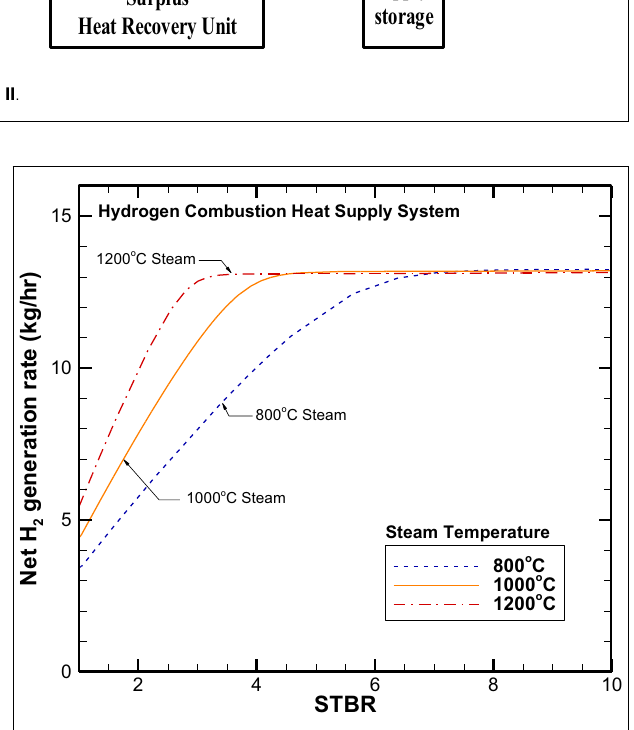
FIGURE 6 | Net hydrogen generation rate for concept system I as a function of STBR